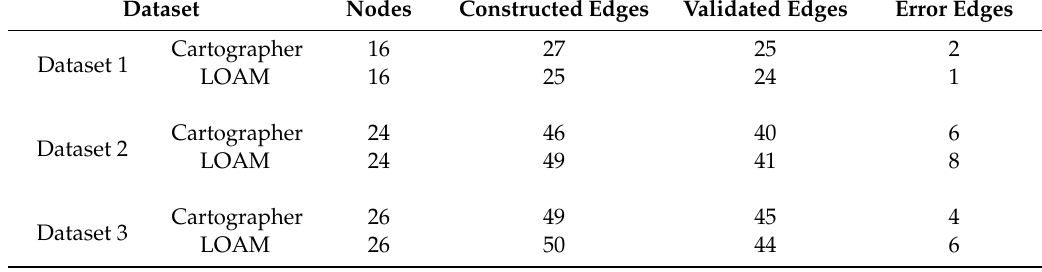
Table 6. Pose graph consistency validation results.